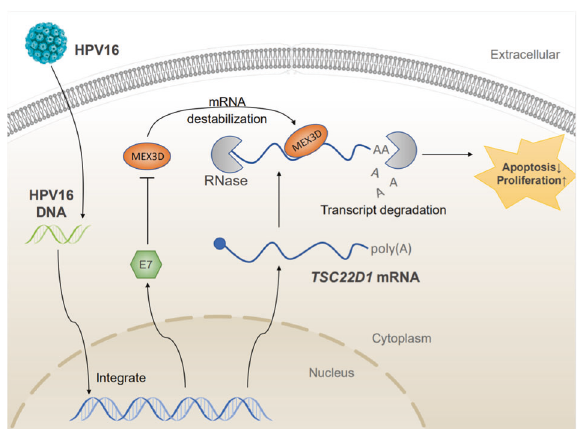
Fig. 7 This article schematic diagram. Suf fi cient quantities of endogenous MEX3D generated during cervical cancer tumorigen- esis are demonstrated by schematic diagram. HPV16 E7 activates MEX3D expression in cervical cancer cells. MEX3D binds to the TSC22D1 mRNA and destabilizes TSC22D1 mRNA and promoting proliferation and reducing apoptosis of cervical